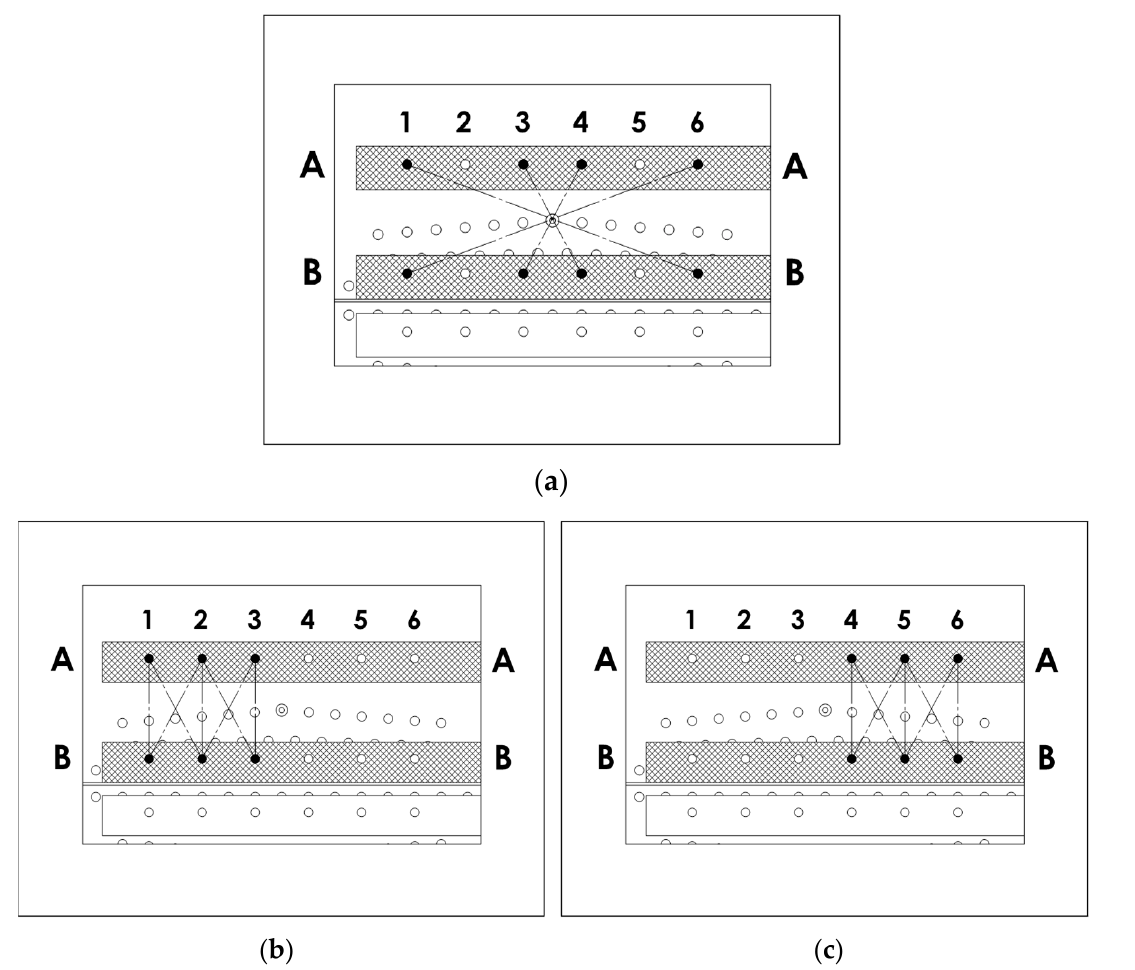
Figure 2. SMART Layer ® transducer locations and wave propagation paths: ( a ) paths crossing the central rivet—referred to as CENTRAL paths; ( b ) paths on the LEFT of the central rivets; ( c ) paths on the RIGHT of the central rivet. A and B indicate two SMART Layers ® used.